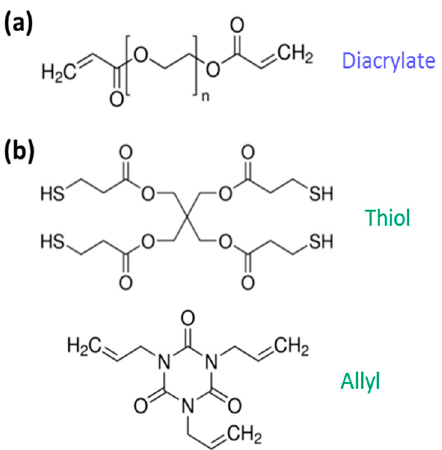
Figure 2. Chemical structure of model monomers used in this work: poly(ethylene glycol) diacrylate (diacrylate) ( a ); and thiol-allyl system ( b ), formed by 1,3,5-triallyl-1,3,5-triazine-2,4,6(1H,3H,5H)-trione and pentaerythritol tetrakis(3-mercaptopropionate) (these two monomers were mixed assuring an equimolar amount of allyl and thiol reactive groups).